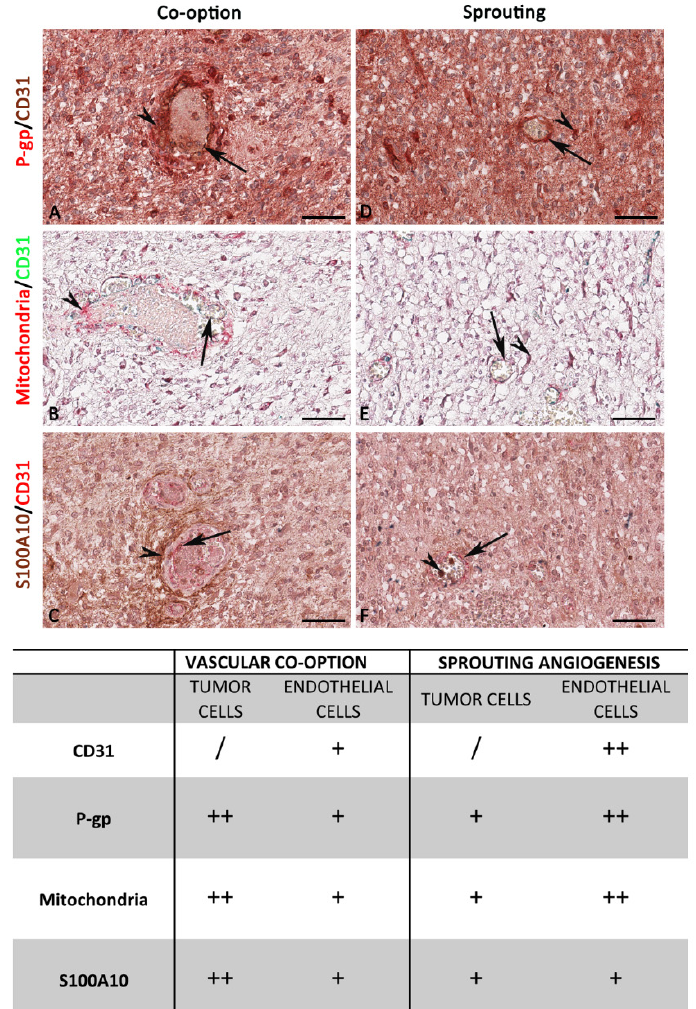
Figure 12. Focus on IDH-WT glioblastoma blood vessels and tumor cells. High magnification of P-gp, mitochondria, S100A10, and CD31 immunohistochemistry reactions, within the same spatial ROIs on IDH-WT glioblastoma serial sections, and the summary table below show the differential expression of these markers by ECs and tumor cells. In the area where vascular co-option occurs, tumor cells overexpressed P-gp ( A ), mitochondria ( B ), and S100A10 ( C ), while ECs do not reveal substantial differences. In the area where sprouting angiogenesis occurs, tumor cells do not reveal substantial differences, while ECs overexpressed P-gp ( D ) and mitochondria ( E ). The table shows the semi-quantitative scoring of IHC reactivity: “/”, very weak or absent; “+”, weak; “++”, intermediate; “+++”, strong. Arrows: ECs; arrowheads: tumor cells. Scale bar: ( A – F ) 16 μ m. In contrast, in the areas of sprouting angiogenesis, the blood vessels appear with an increased CD31 expression, P-gp/CD31 (Figure 11E), and mitochondria/CD31 (Figure 11K) co-expression, which is indicative of ECs proliferation and migration (Figure 12). The differences in S100A10/CD31 co-expression were insignificant in the two methods of tu- mor growth (Figure 13A).